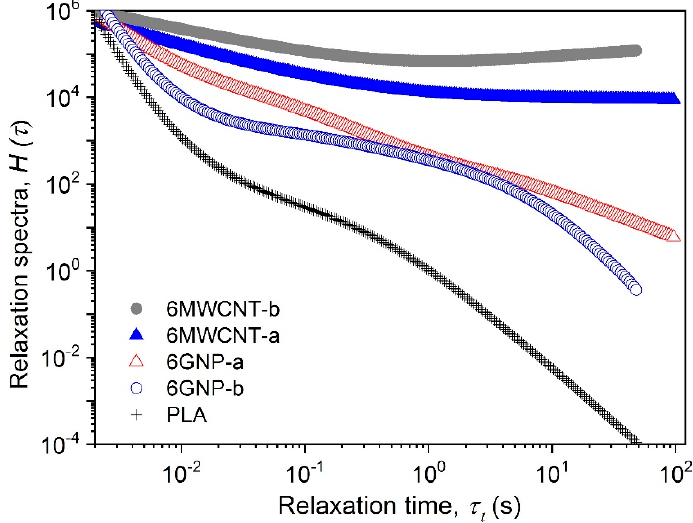
Figure 3. Relaxation time spectra of PLA nanocomposites with 6 wt.% filler content. Comparison of GNP-a, GNP-b, MWCNT-a and MWCNT-b nanocomposites with neat PLA.